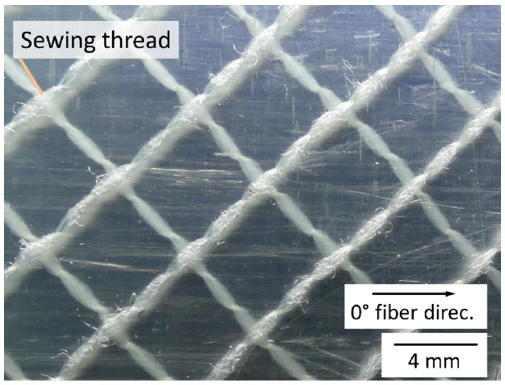
Figure 5. Top view of the composite after removing the top aluminium layer.